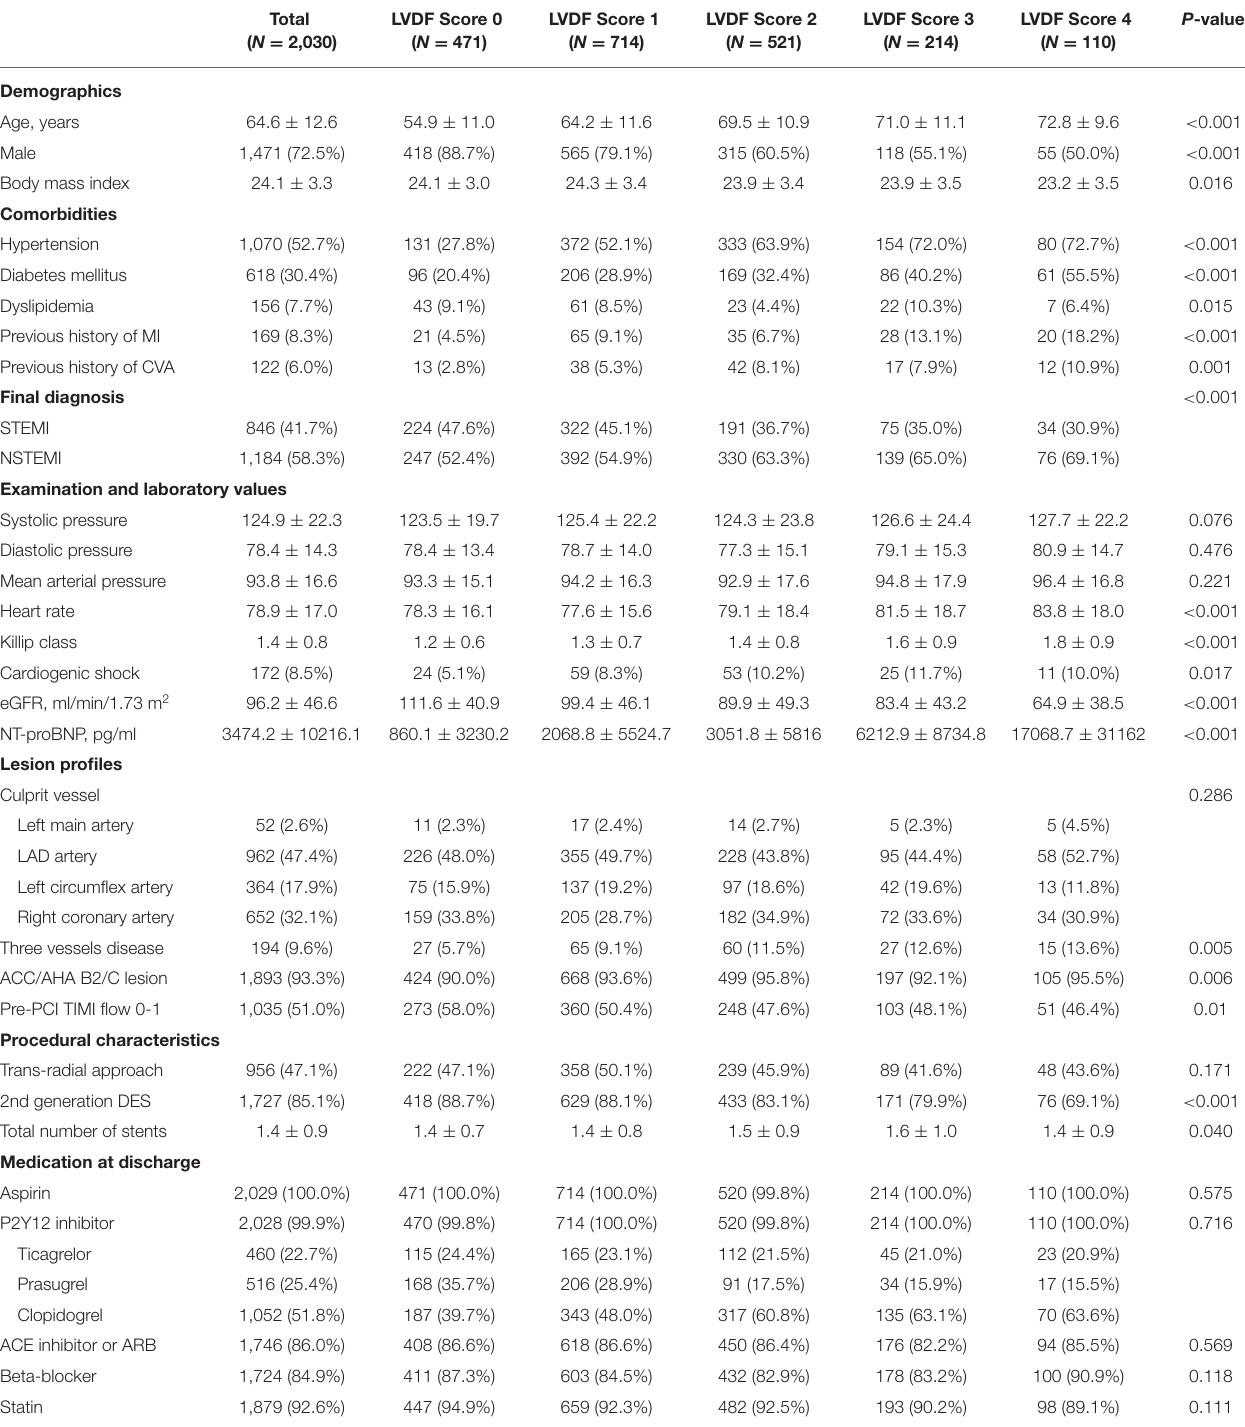
TABLE 1 | Baseline Clinical and Procedural-related